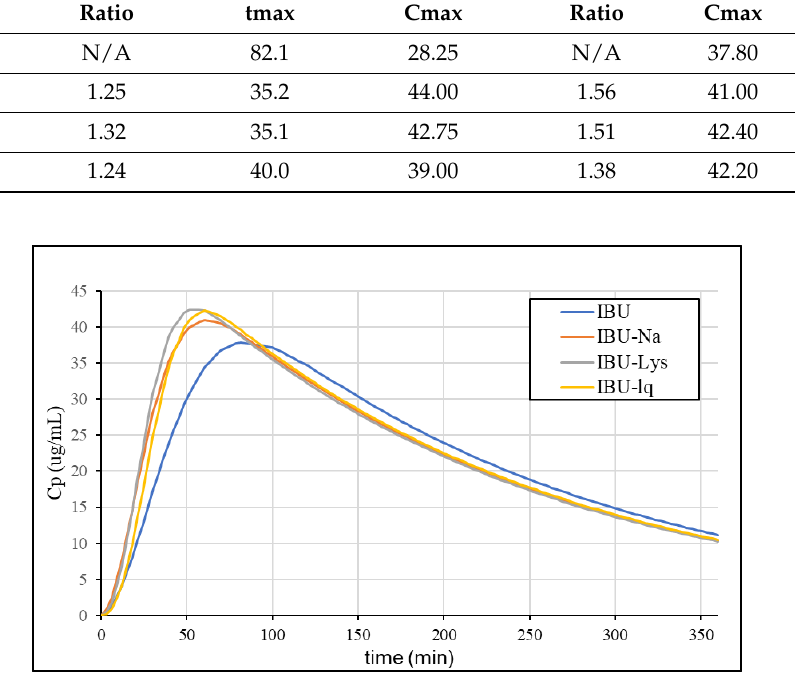
Figure 12. The simulated plasma concentration profiles of ibuprofen formulations.